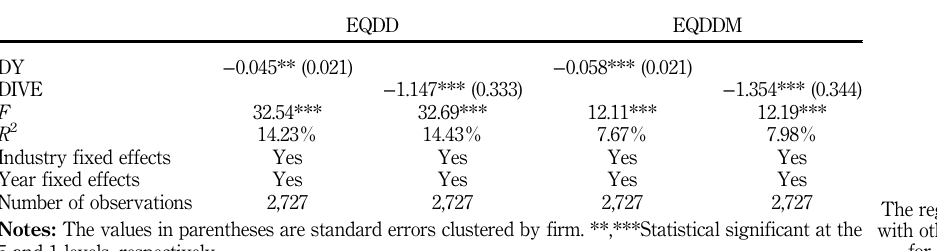
Table VI. The regression results with other two proxies for dividend